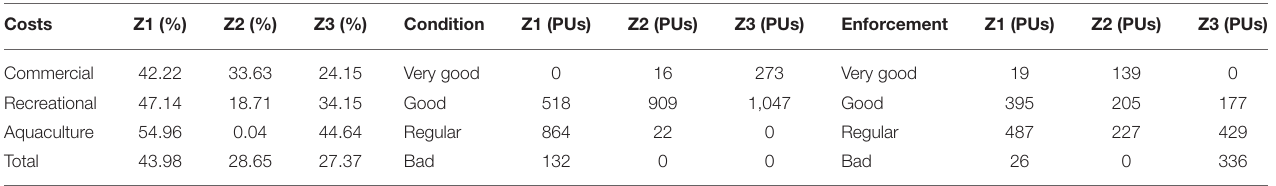
TABLE 6 | Percentage of the opportunity cost (Costs) for commercial, recreational, and aquaculture for the three zones as a sum of the cost of each planning unit selected in the best solution divided by the total opportunity